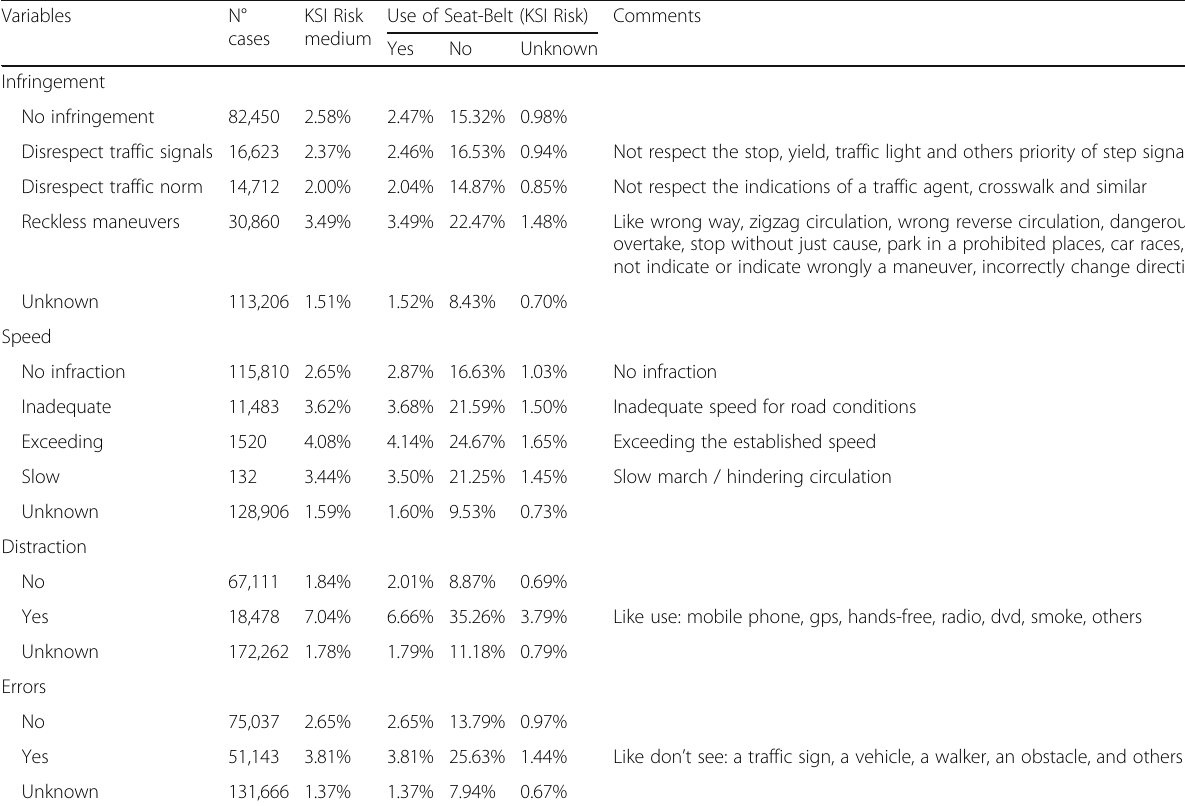
if the driver does not use the seat belt. Table 6 Probabilities of suffering a serious injury, depending on the use of seat belt and the different variables of the human factor. Processed by the Authors